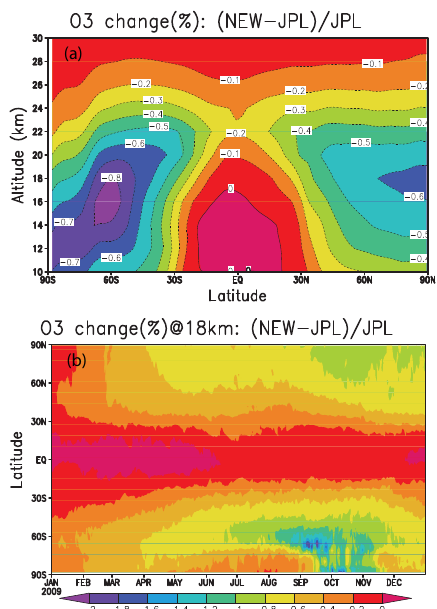
Fig. 9. Difference in ozone from a simulation of the SLIMCAT 3- D CTM with scaled J ( BrONO 2 ) ( × 1 . 27) and k BrO + NO compared to a run with standard JPL kinetics. (a) Difference (%) in annually and zonally averaged ozone and (b) difference (%) in zonal mean ozone at 18km as a function of time. Note the different colour scales in the two